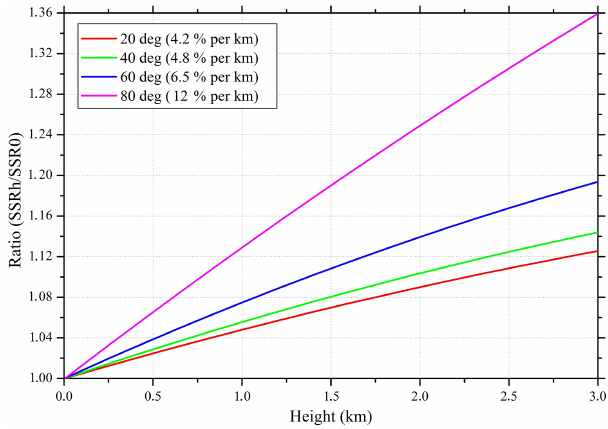
Figure 4. The altitude correction of GHI for various SZAs as a func- tion of the SSR ratio (SSR at height h compared to SSR at sea